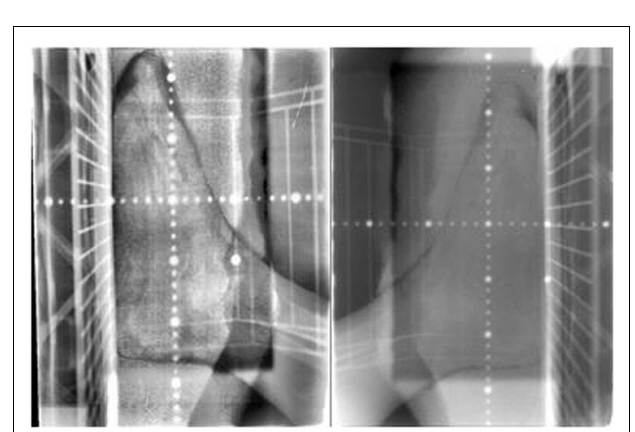
FIGURE 4 | MV portal films of left lateral (left) and right lateral (right) for patient C